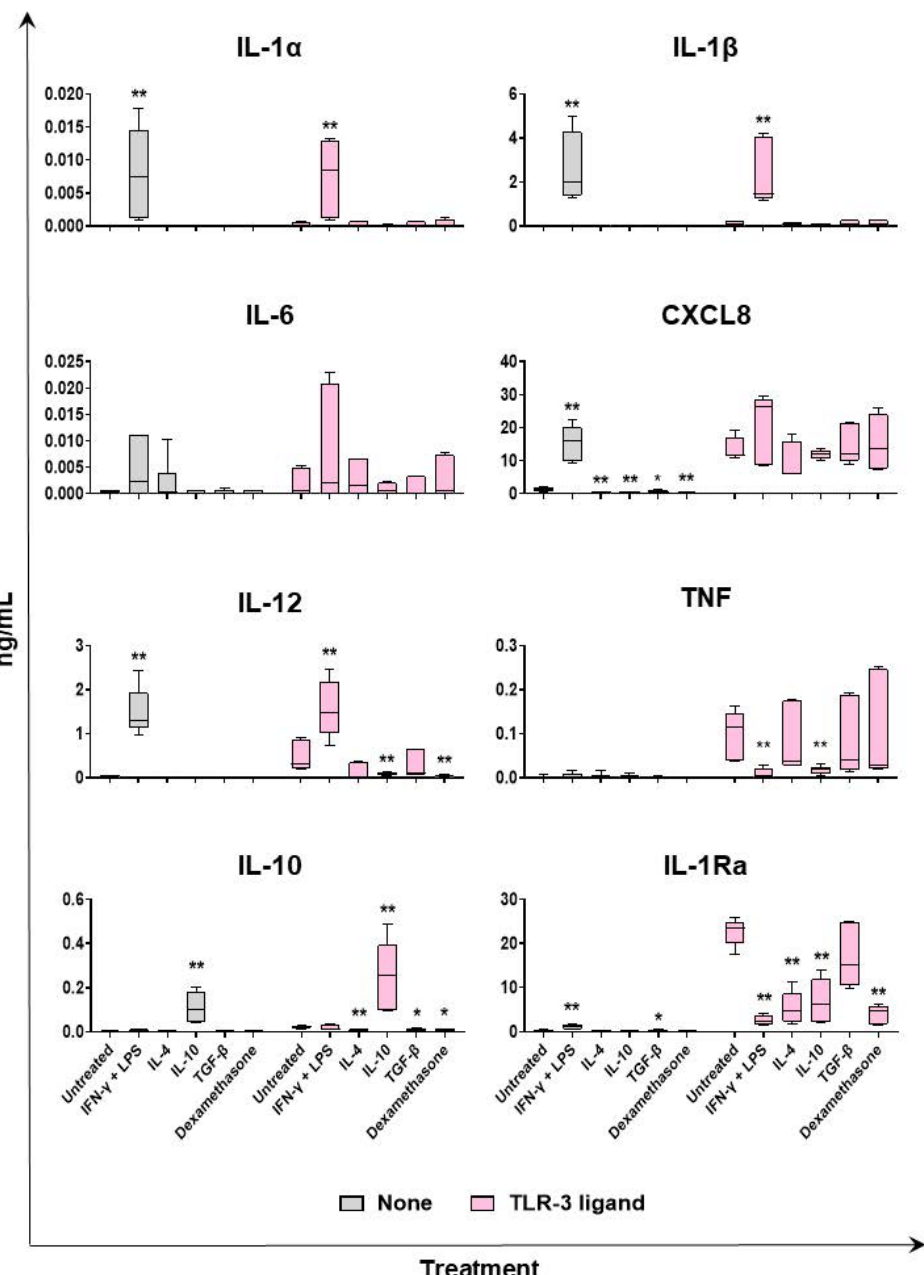
Figure 8. Ability of diverse macrophage subsets to release proinflammatory and anti-inflammatory cytokines in response to TLR3 agonist stimulation. The moM Φ were left untreated, or they were stimulated with diverse polarizing factors: IFN- γ + LPS (both at 100 ng/mL, moM1), IL-4 (20 ng/mL), IL-10 (20 ng/mL), TGF- β (20 ng/mL), or dexamethasone (20 ng/mL). Then, 24 h later, culture supernatants were replaced with fresh media and cells were left untreated or activated using a TLR-3 ligand (Poly I:C, 100 ng/mL); 24 h later, the amounts of IL-1 α , IL-1 β , IL-6, CXCL8, IL-12, TNF, IL-1Ra, and IL-10 in culture supernatants were determined using a multiplex ELISA. Data from three independent experiments utilizing different blood donors are presented. Data are displayed as box-and-whisker plots, showing the median and interquartile range (boxes) and minimum and maximum values (whiskers). For each cytokine (IL- α , IL- β , IL-6, CXCL8, IL-12, TNF, IL-1Ra, and IL-10), for both unstimulated and Poly I:C-stimulated moM Φ , values of treated macrophages were compared to the untreated control (moM Φ ) using of a Mann–Whitney test. ** p < 0.01, and * p <